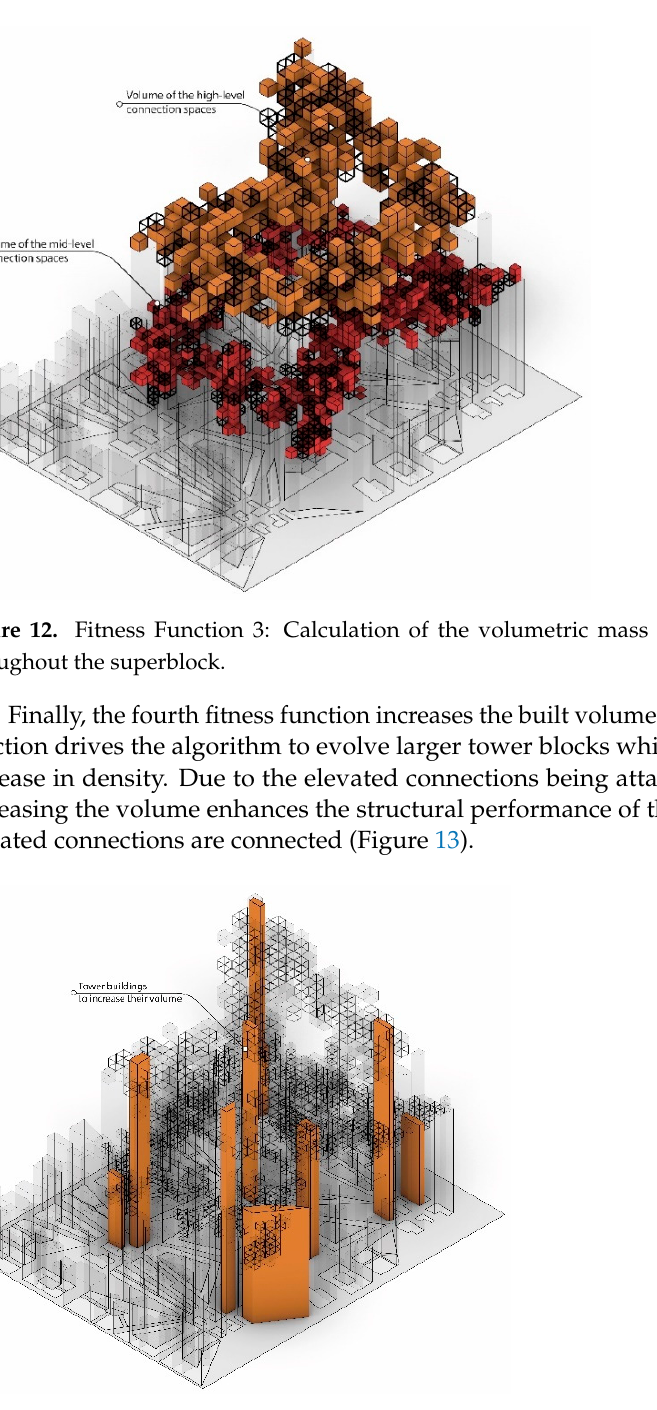
Table 1. Simulation and algorithm settings. Simulation Size